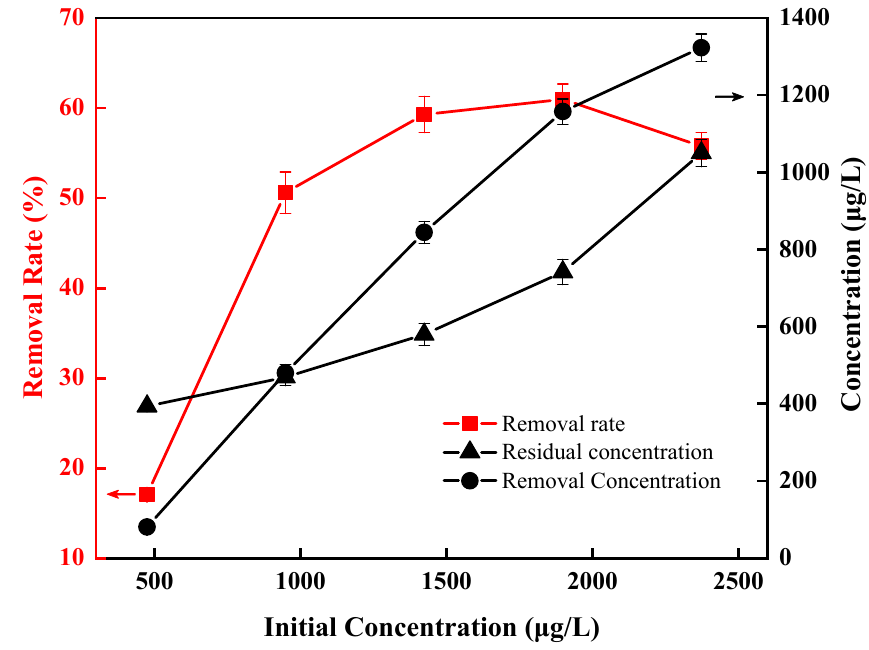
Figure 9. Effect of initial concentration on direct removal of Anabaena by DEP.